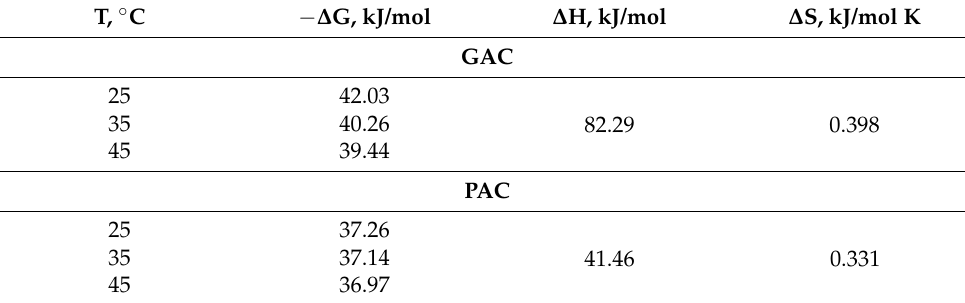
Table 3. Thermodynamics of DNS adsorption in GAC and PAC.